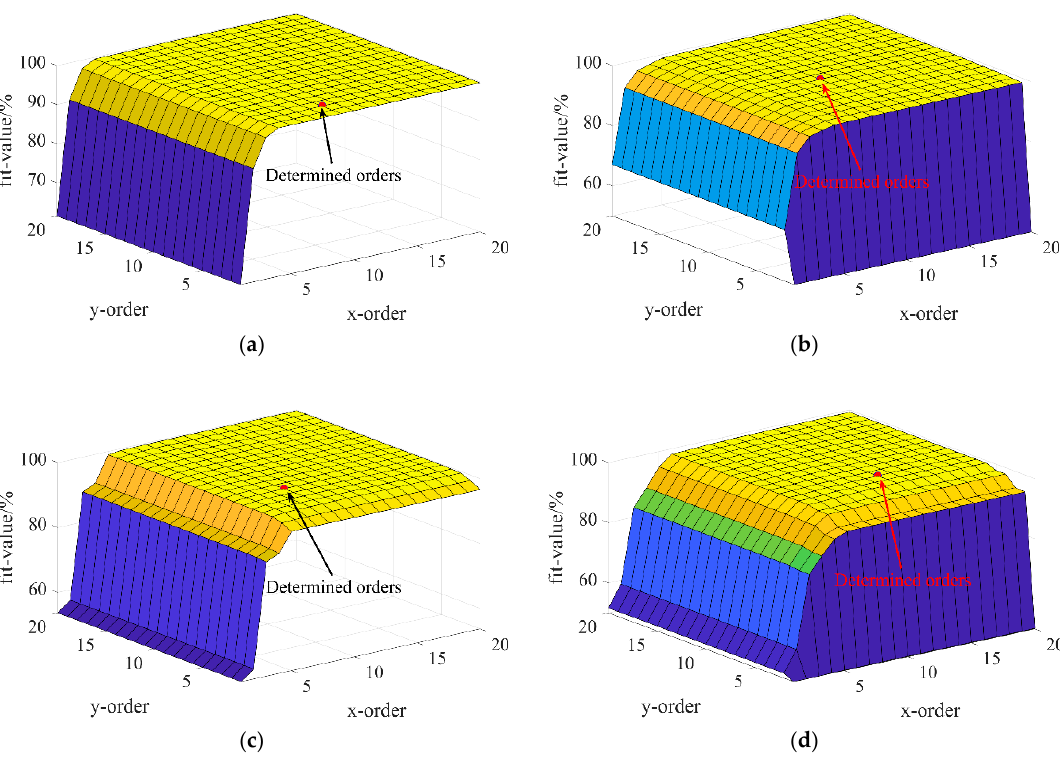
Figure 8. The fit value of first four modes against polynomial function orders. ( a ) The first bending mode at 49.02 Hz. ( b ) The first torsion mode at 237.70 Hz. ( c ) The second bending mode at 311.52 Hz. ( d ) The second torsion mode at 781.25